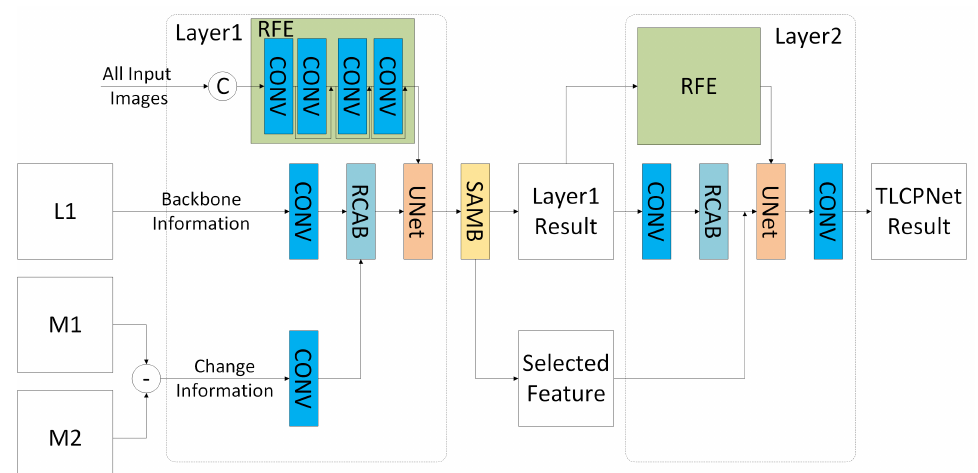
Figure 4. Architecture of the TLCPNet.